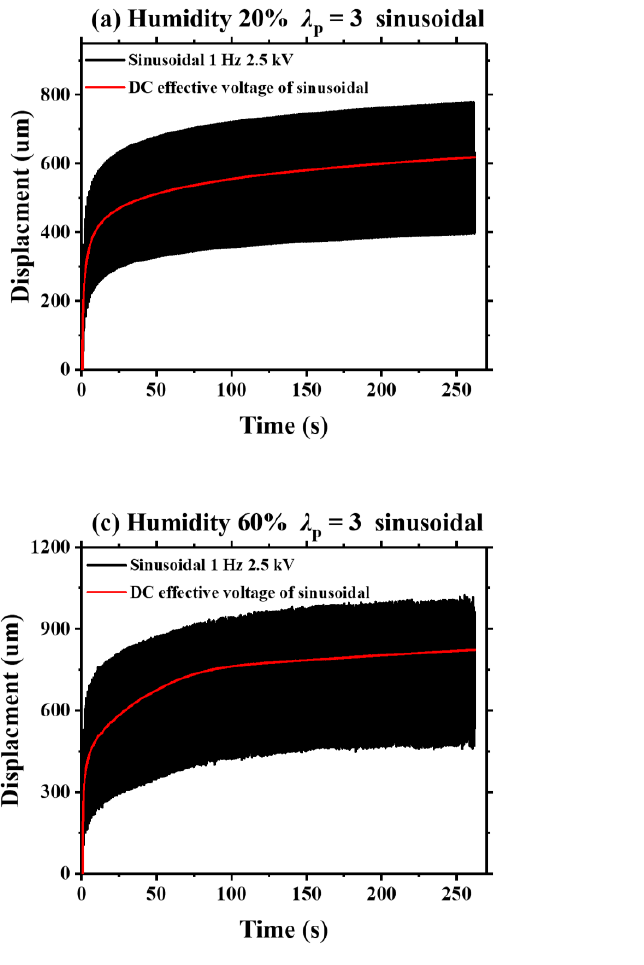
Figure 8. Comparison of the displacements between the effective DC signal and the sinusoidal signal under different ambient humidities.